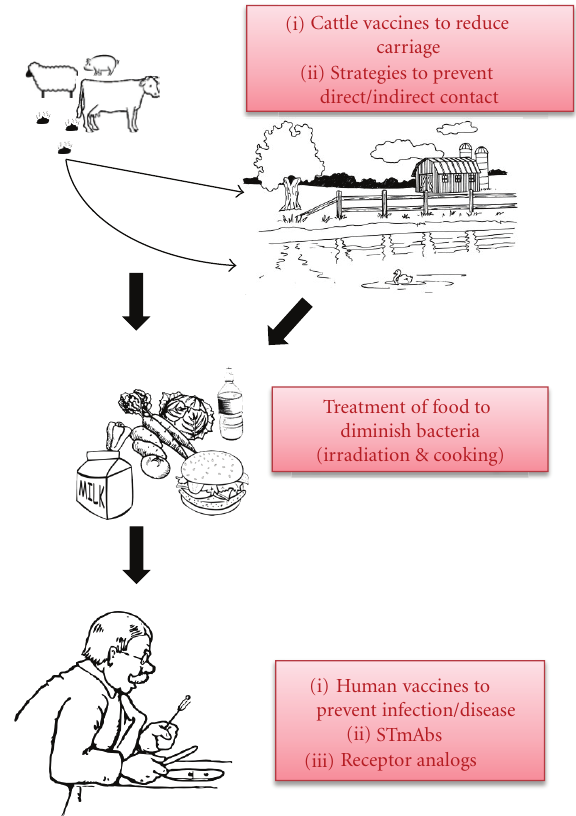
Figure 2: Modes of E. coli O157:H7 transmission to humans with emphasis on strategies for prevention/intervention. Other modes of transmission of E. coli O157:H7 have been reported and are described